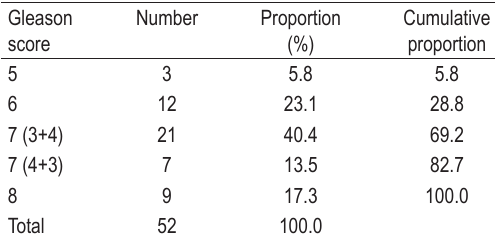
TABLE 1. Distribution of Gleason scores in 52 cases of prostatic adenocarcinoma